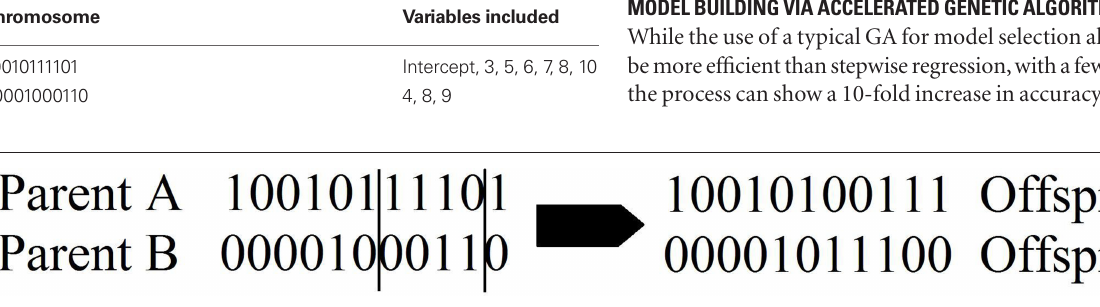
Figure 1 | Diagram of crossover with two